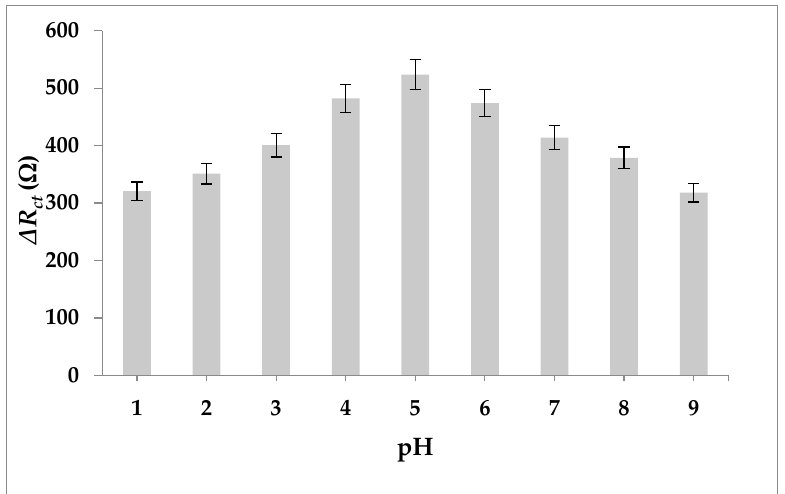
Figure 10. Effect of pH on analytical performance of the aptasensor in the presence of 0.33 nM MDMA.